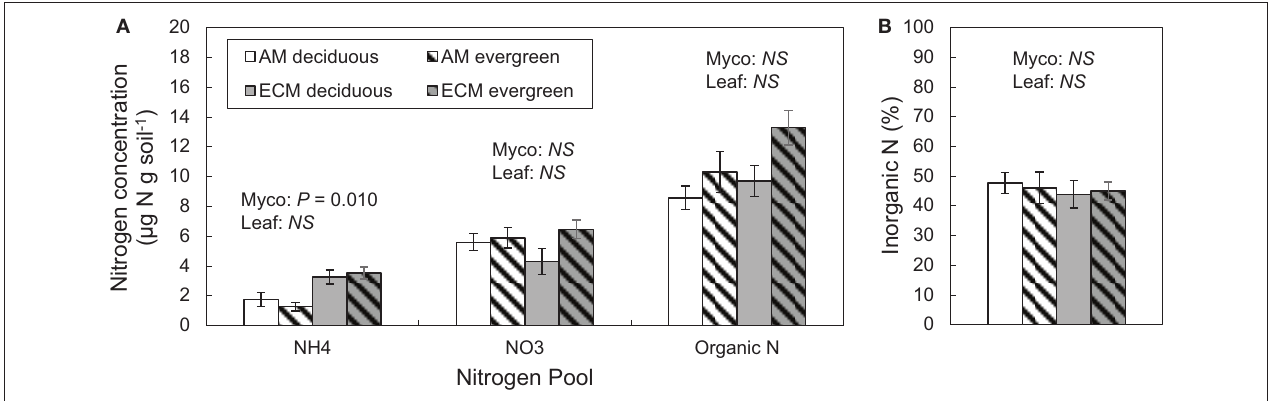
FIGURE 3 | Soil nitrogen pools (A) and the proportion of inorganic N in the extractable N pool (B) in forestry plots at The Morton Arboretum. Bars are mean ratios; one standard error of the mean is presented. Open bars, deciduous plots; hatched bars, evergreen plots; white bars, AM plots; gray bars, ECM plots.